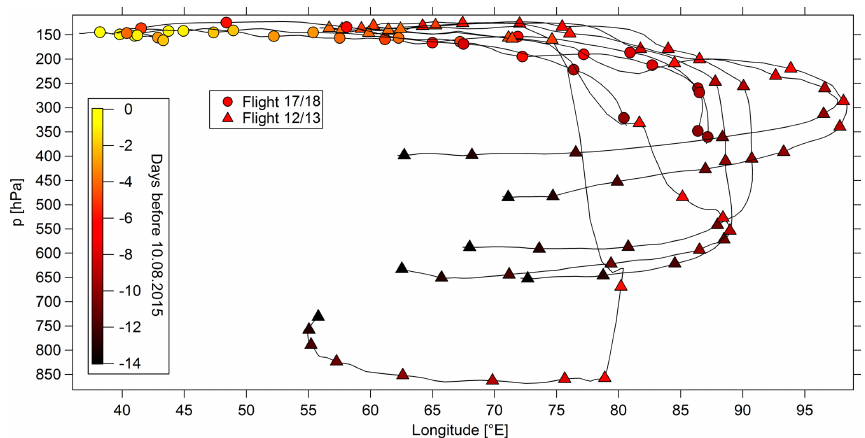
Figure 25. Centroid back trajectories for enhanced CH 4 mixing ratios during flight 12/13 (triangles) and flight 17/18 (circles) with colour- coded days before the release on 10 August